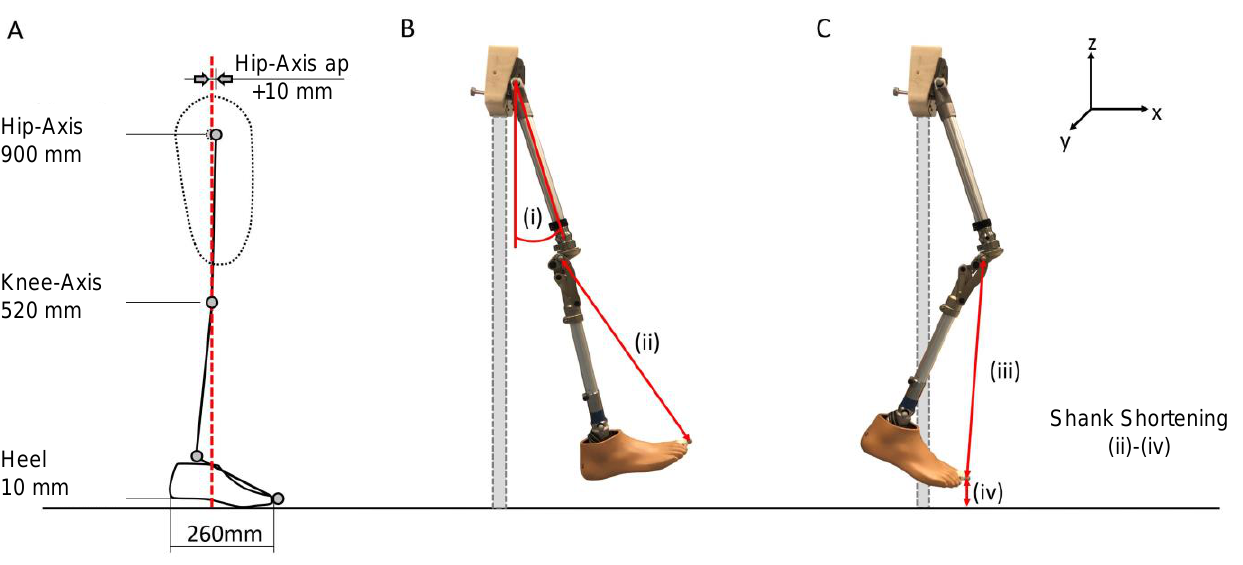
Figure 2: Schematic illustration of: (A) Prosthetic alignment. (B) Experimental setup with knee joint in full extension, (i) hip flexion angle (individual tube inclination was considered), (ii) distance between knee (extended) and big toe marker. (C) Experimental setup when knee joint is flexed, (iii) distance between knee (flexed) and big toe marker, (iv) minimum ground clearance.